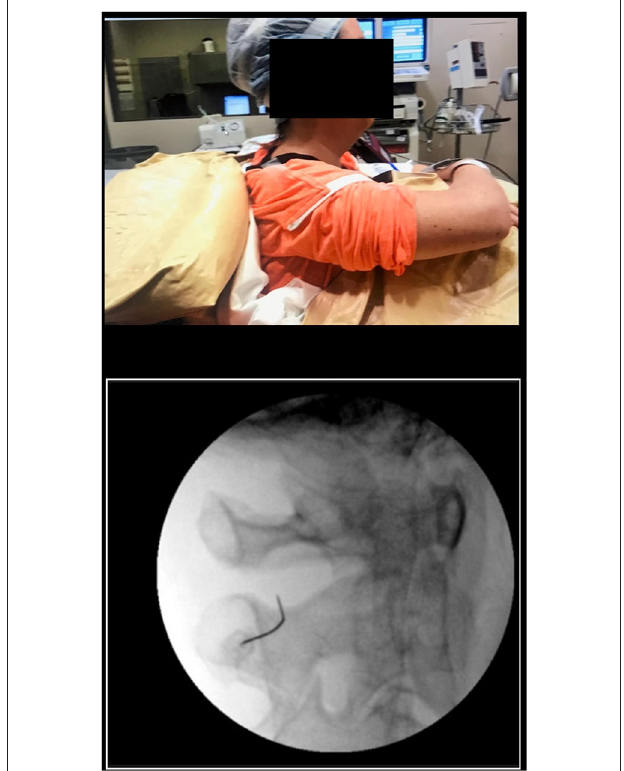
FIGURE 1 | (A) The patient seated in preparation for the procedure with an inflatable bag used to maintain posture. (B) Fluoroscopy picture showing the position of the anesthesia needle between C1 and C2 spinal